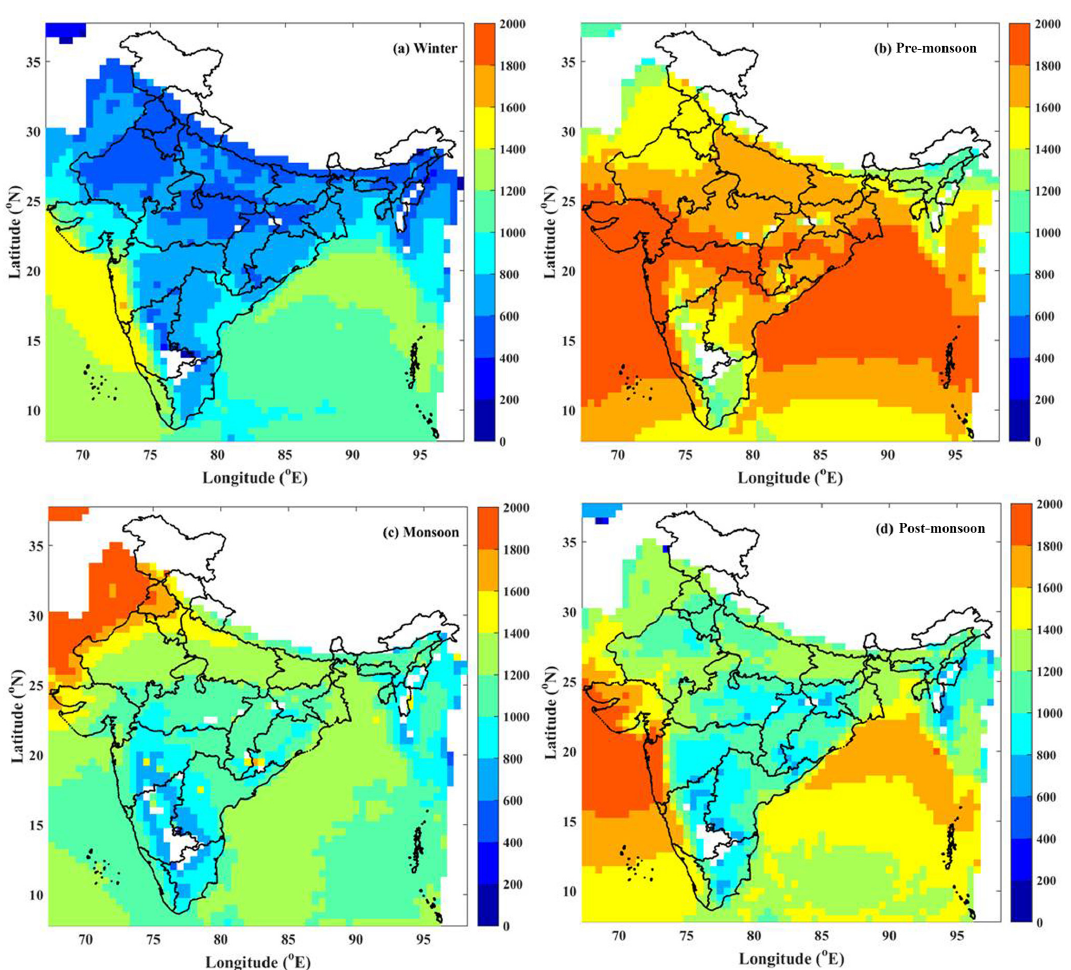
Figure 6. The distribution of CAPE (Jkg − 1 ) during (a) winter, (b) pre-monsoon, (c) monsoon, and (d) post-monsoon from INSAT-3D data over the Indian